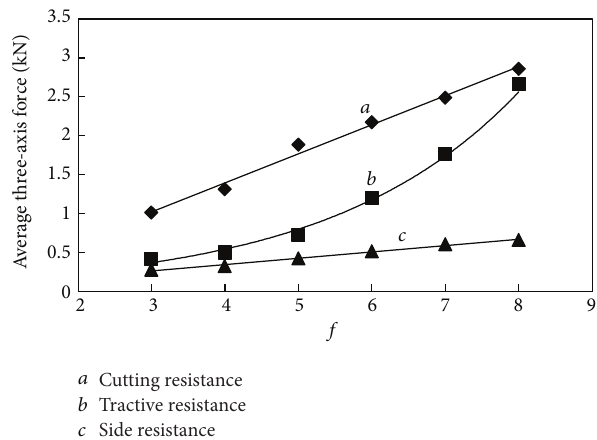
Figure 10: Relationship between average three-axis force and 𝑓 .